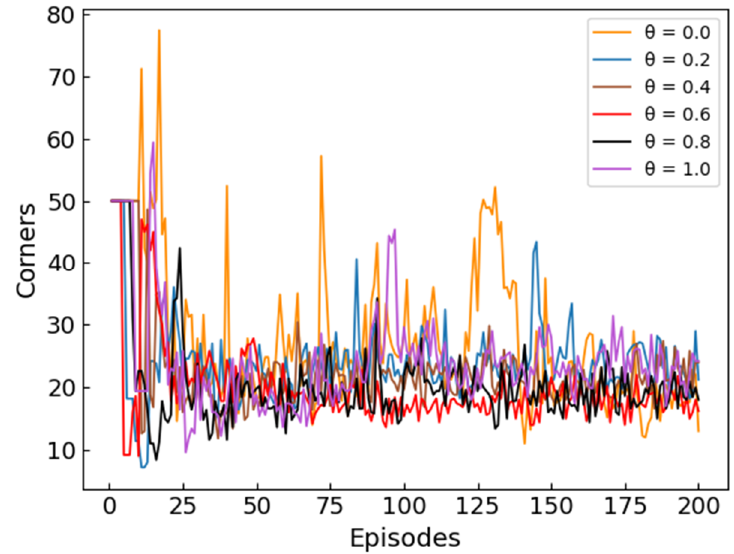
Figure 10. The corners change process of each set of parameters.